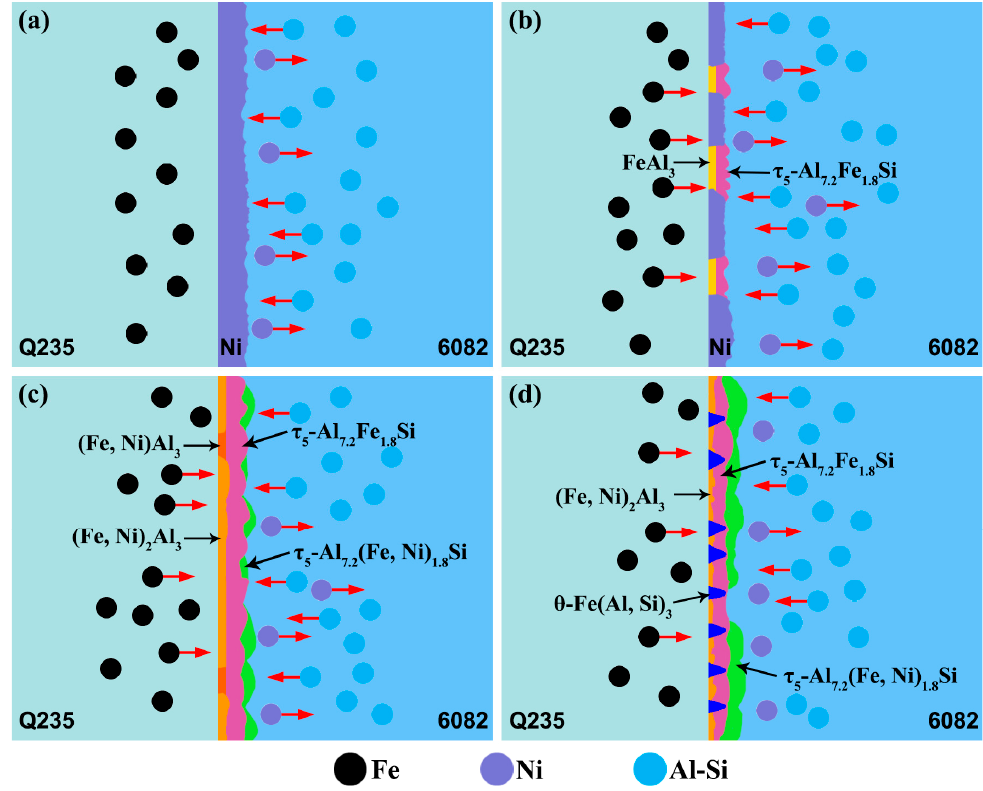
Figure 6. Interface reaction layer growth mechanism of Al alloy/steel joint with Ni coating: ( a ) stage I; ( b ) stage II; ( c ) stage III; ( d ) stage IV.